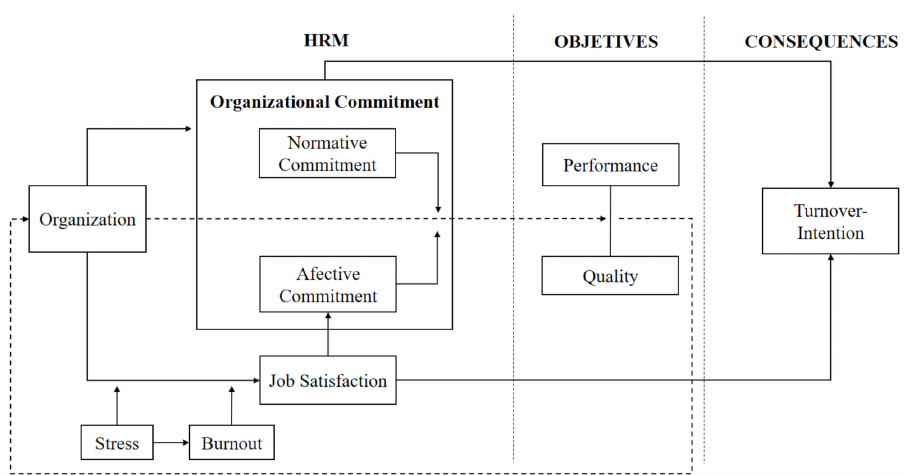
Figure 3. Organizational commitment model in healthcare organizations. Source: prepared by the